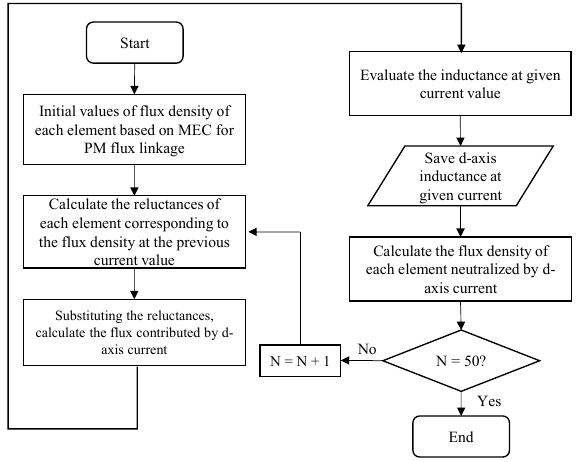
Figure 4. Flowchart for D-axis inductance calculation.